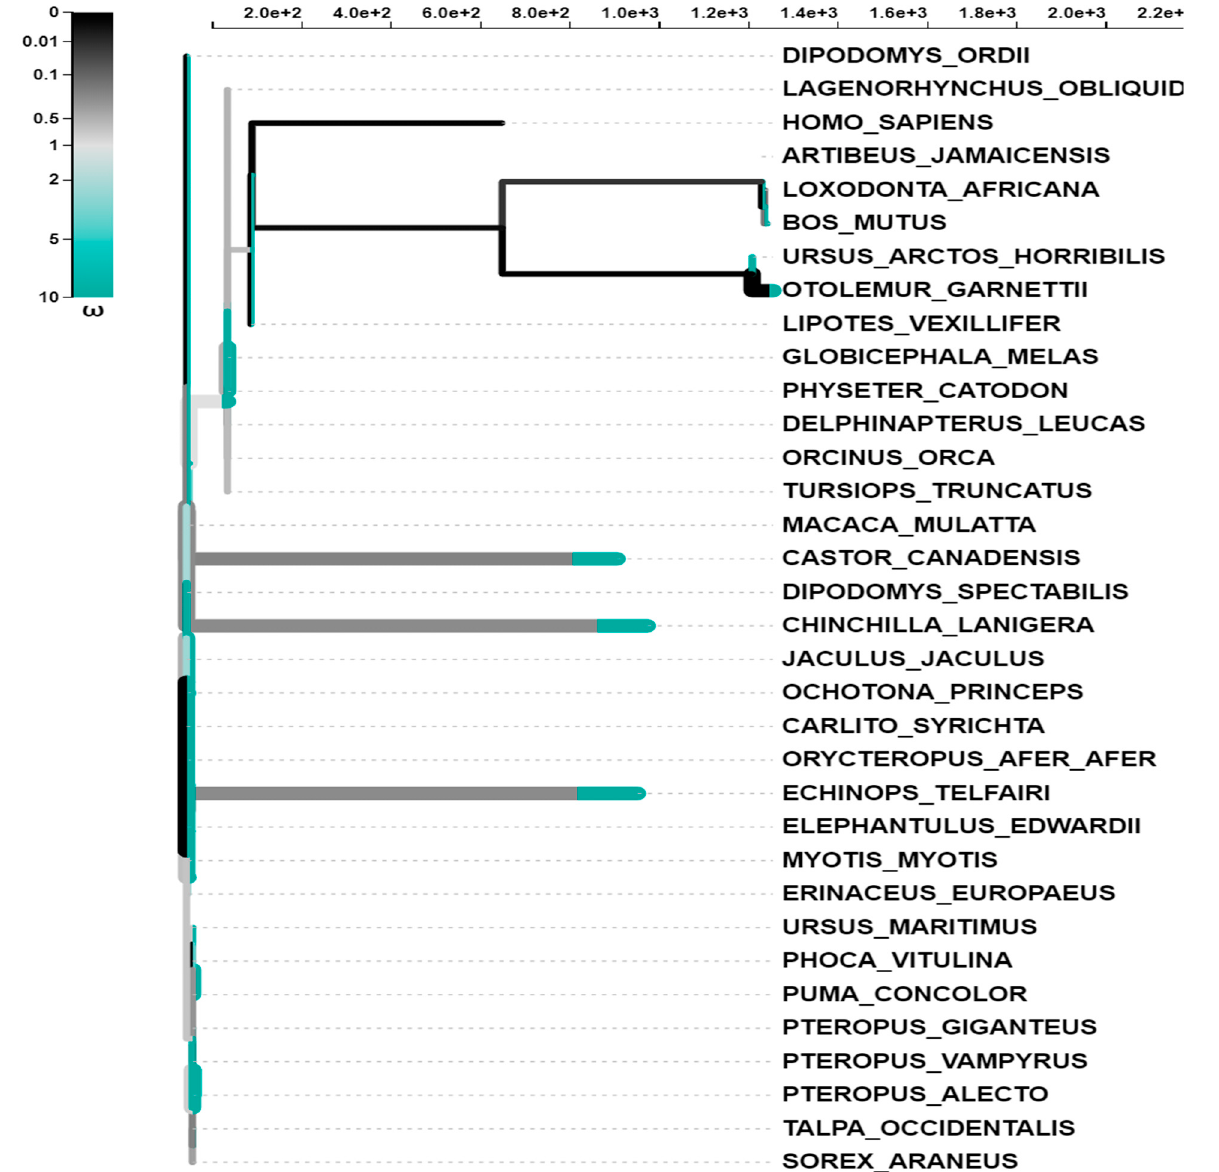
Figure 3. The aBS-REL models used to undertake selective analyses of vertebrate activating transcription factor genes. The length of the branch is separated into segments based on the percentage of sites that correspond to each class, and the color of the branch segment shows the relative relevance of the relevant parameters. Because of this, sites along a branch can be categorized according to the β distribution that has been inferred. Depending on whether or not the site has a p value of less than 0.05 (adjusted for multiple testing), thicker branches are categorized as having either undergone diversifying positive selection or diversifying negative selection. This determination is based on whether or not the null hypothesis is rejected.